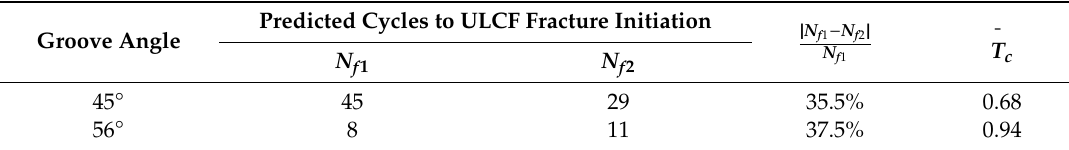
Table 9. Calculation results of ULCF life of steel bridge